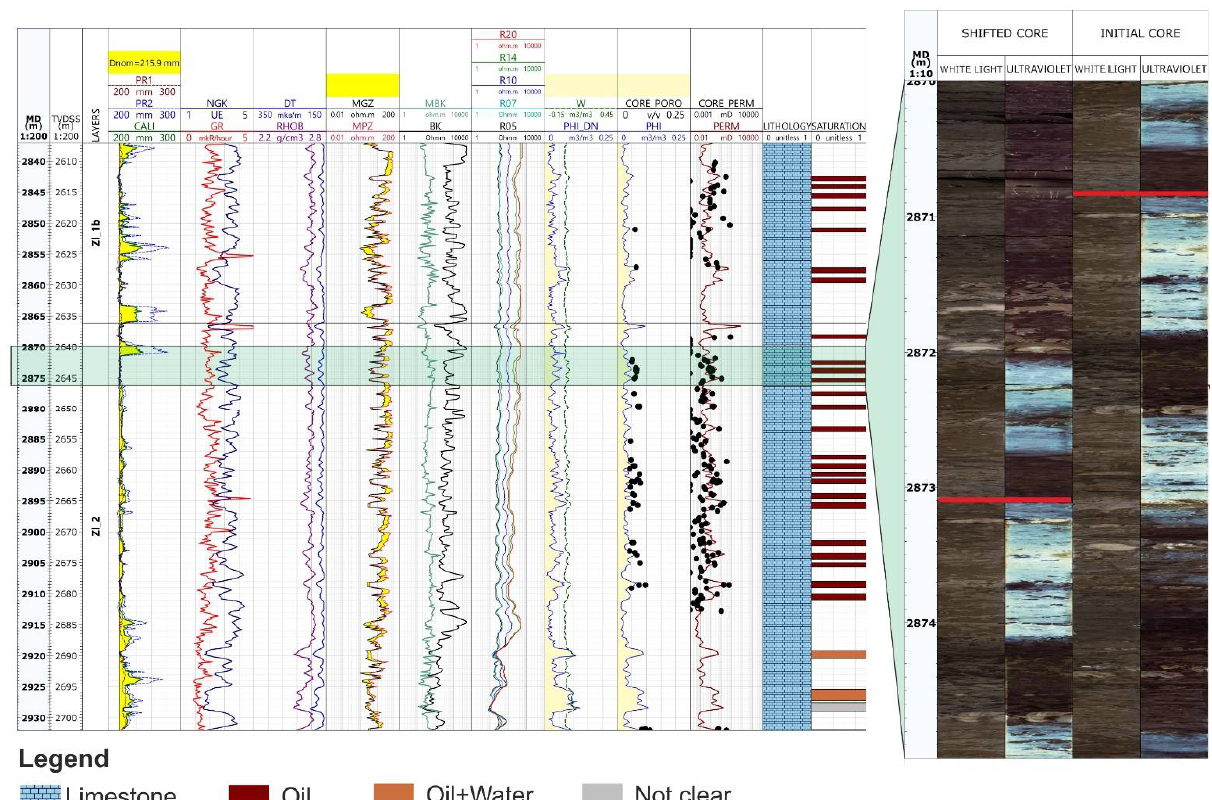
Figure 4. Well-logging interpretation and core shifting. Core was shifted using the comparison of core and log gamma ray measurements. This method provides an accurate estimation of shifting intervals. Continuous porosity and permeability curves are obtained from previous log interpretation. (CALI, PR1, PR2—calipers; NGK—neutron gamma log, MBK, MGZ, MPZ—microlaterologs, BK—laterolog; R05-R20—high-frequency electrical logging).